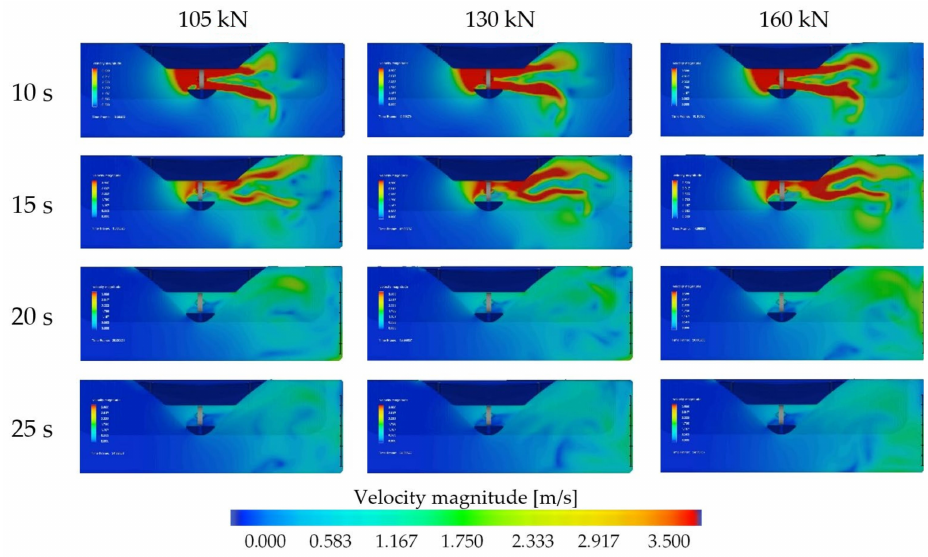
Figure 13. Bow thruster-generated flow distribution in the bow thruster symmetry plane between the C3 and C4 lines in 15 s, 20 s and 25 s of time simulation—both the bow thrusters operating with the thrusts 105 kN, 130 kN and 160 kN each, respectively, during the period of time of 10